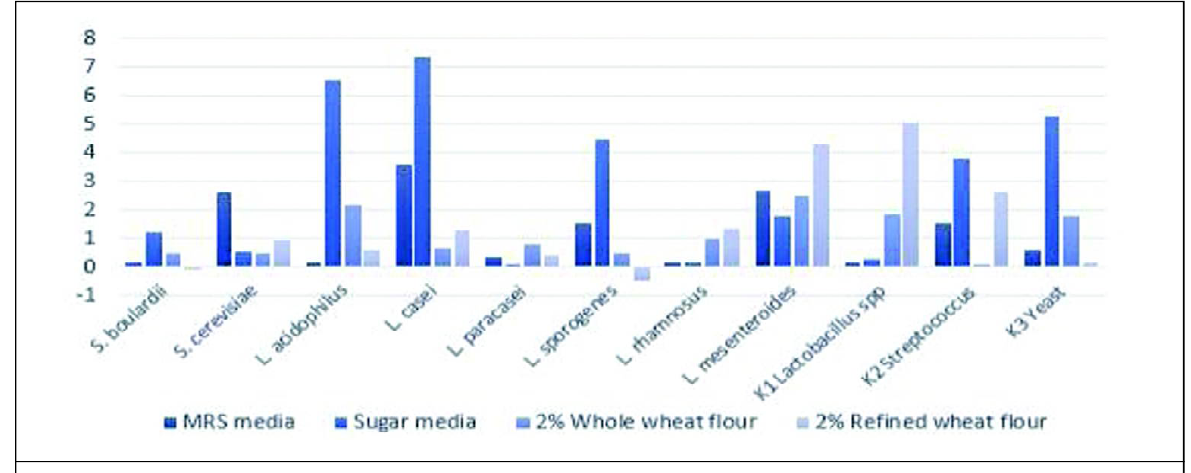
Graph 1: Relative acid production by organisms in different